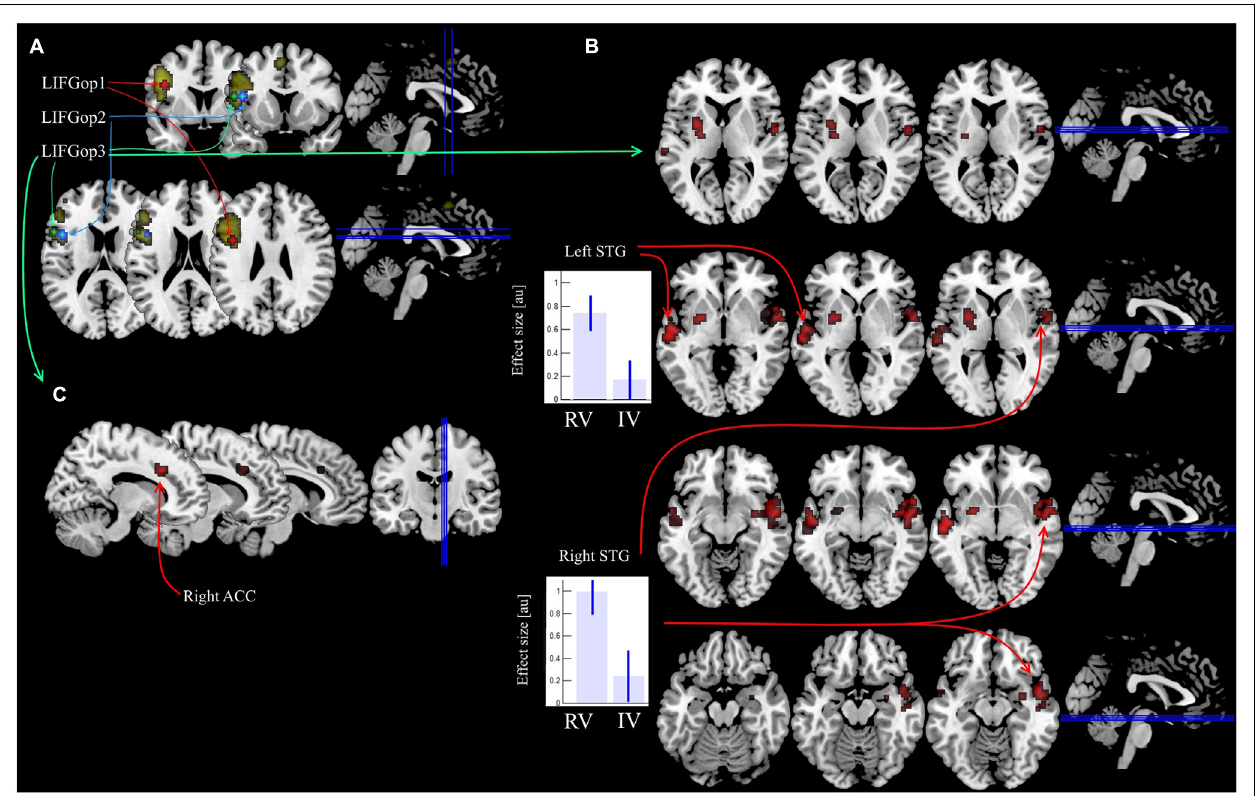
FIGURE 1 | Location of ROIs in the LIFG and results of PPI analysis. (A) Three ROIs overlaid on the areas Slioussar etal. (2014) identified as sensitive to the main effect of regularity (regular real and nonce verbs were compared with irregular real and nonce verbs). (B) Increase in functional